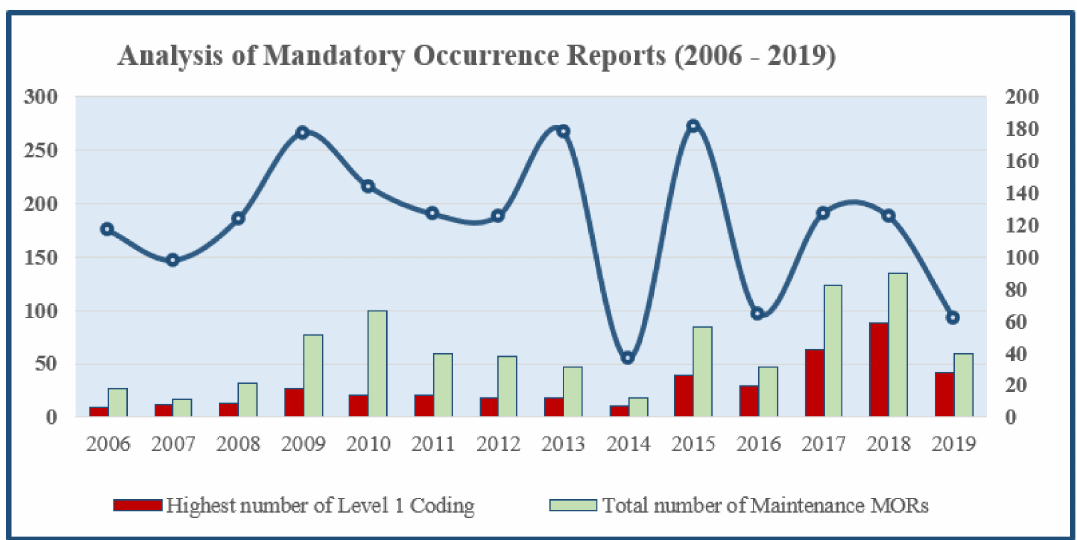
Figure 3. Analysis of maintenance-related MORs (Mandatory Occurrence Reports) between 2006 and